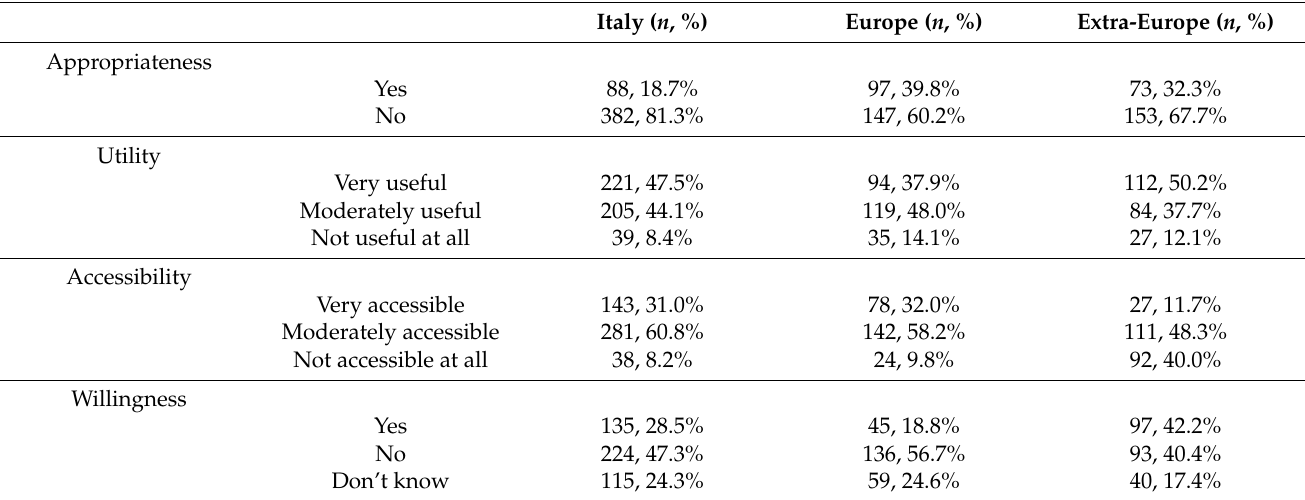
Table 1. Opinion of Italian stakeholders in Italy, Europe, and extra-European countries about appro- priateness, utility, and accessibility of online psychological interventions, and their willingness to use them. Italy ( n , %) Europe ( n , %) Extra-Europe ( n , %) Yes 88, 18.7% 97, 39.8% 73,